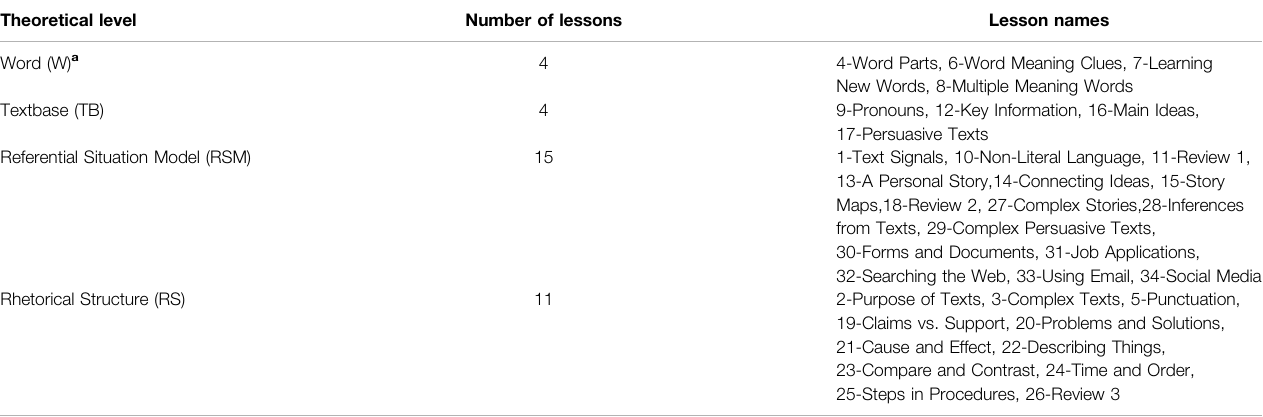
TABLE 1 | Distribution of Primary Theoretical Levels Across the 34 lessons. Theoretical level Number of